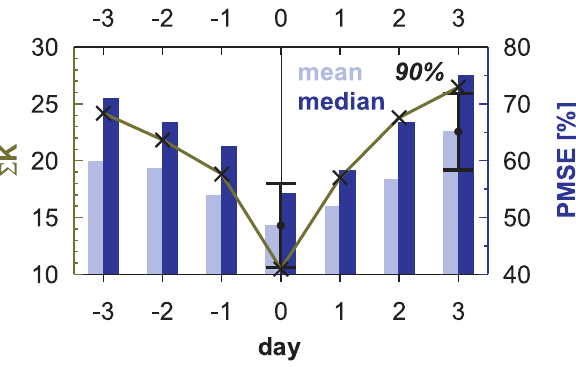
Fig. 4. Superimposed epoch analysis of the PMSE occurrence rates (blue bars) and of the corresponding 6K indices at Tromsø (green curve) during 51 intervals from 1999–2005 using minimum 6K values at key day 0 (for details see